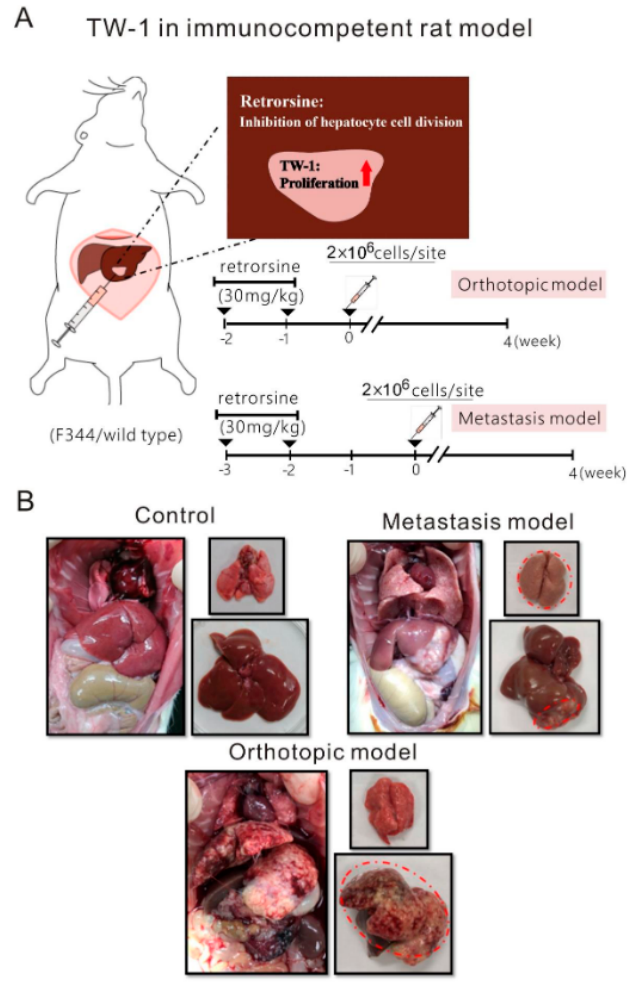
Figure 5. Metastasis of TW-1 in immunocompetent wild-type rats. ( A ) The schematic design of the orthotopic and metastasis rat models. TW-1 cells were injected into the liver of an immunocompetent rat one or two weeks after the retrorsine treatment. ( B ) Rats were sacrificed 4 weeks after the TW-1 injection for both models.